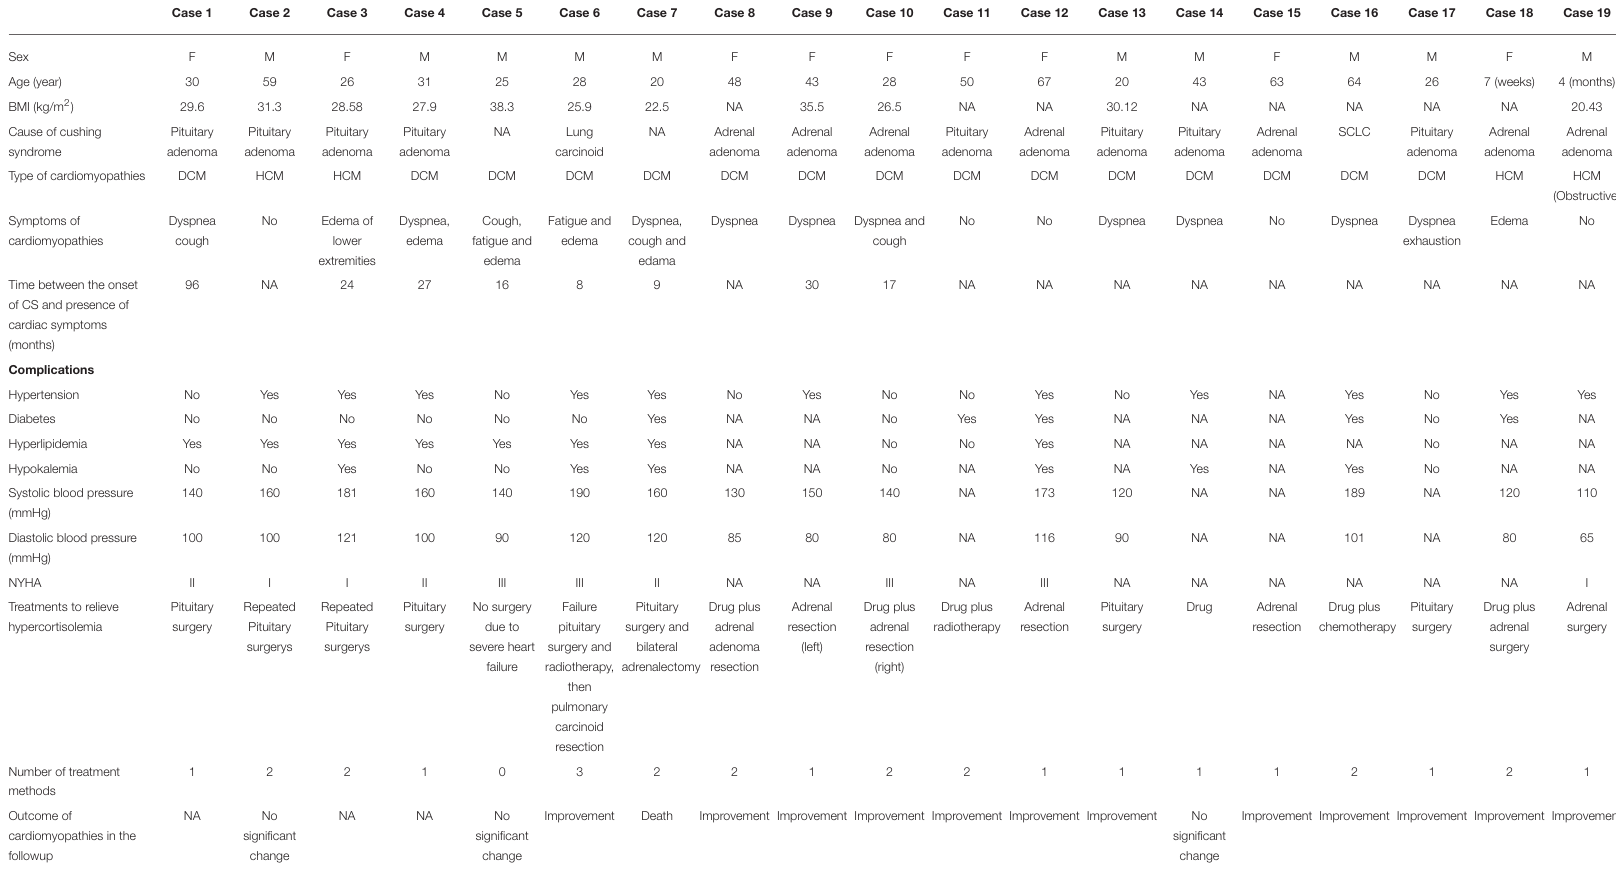
TABLE 1 | Clinical characteristics of CS complicated with